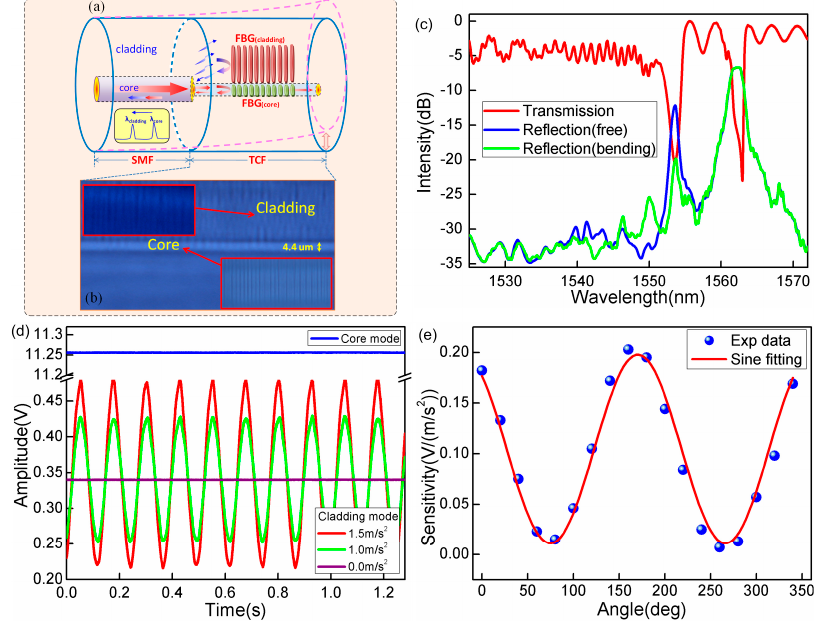
Figure 5. ( a ) Schematic diagram of TCF-FBG directional accelerometer; ( b ) Image of TCF-FBG, insets show the zoomed images of gratings in fiber cladding (up) and fiber core (bottom); ( c ) The transmission spectrum of TCF-FBG with two well-defined resonances; ( d ) Real-time power output of cladding mode and core mode (blue curve) under the same vibration condition; ( e ) Angular dependence of acceleration responsivity of sensor.